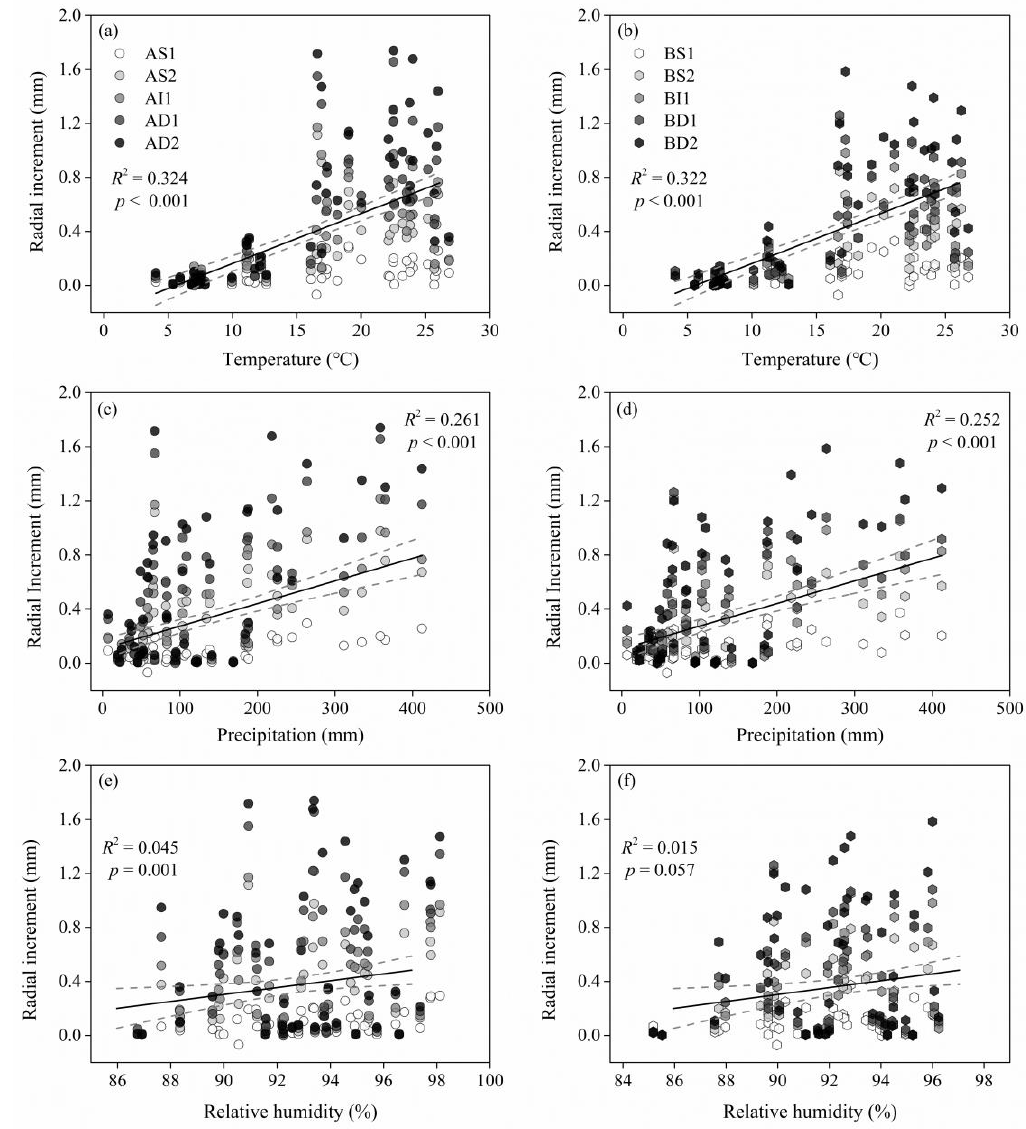
Figure 7. Linear relation of climate factors and radial growth. ( a ) Temperature and growth in site A, ( b ) temperature and growth in site B, ( c ) precipitation and growth in site A, ( d ) precipitation and growth in site B, ( e ) Relative humidity (RH) and growth in site A, and ( f ) RH and growth in site B. The grey dashed line represents 95% confidence interval (CI).